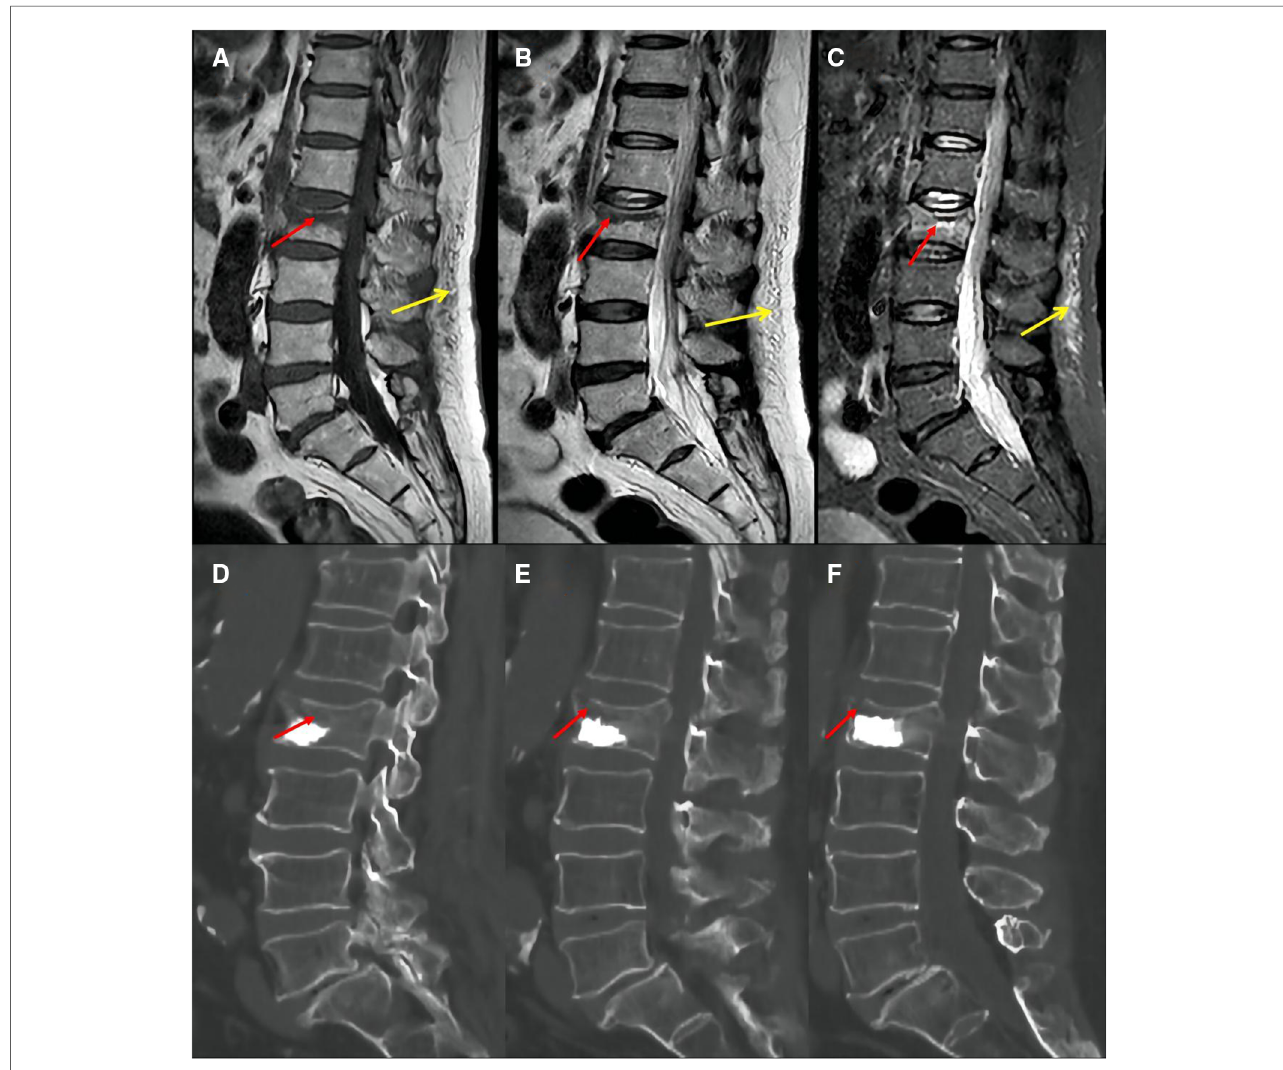
FIGURE 4 Preoperative MRI images showed that the fracture area was located in the upper third of the vertebral body ( A : T1, B : T2, C : STIR, red arrow); postoperative CT images showed insuf fi cient cement fi lling in the vertebral fractured area ( D : left in median sagittal section; E : median sagittal section; F : right in median sagittal section, red arrow). Posterior fascia edema:hypointense on T1-weighted images ( A , yellow arrow); hyperintensity on T2-weighted images ( B , yellow arrow) or STIR images ( C , yellow arrow).